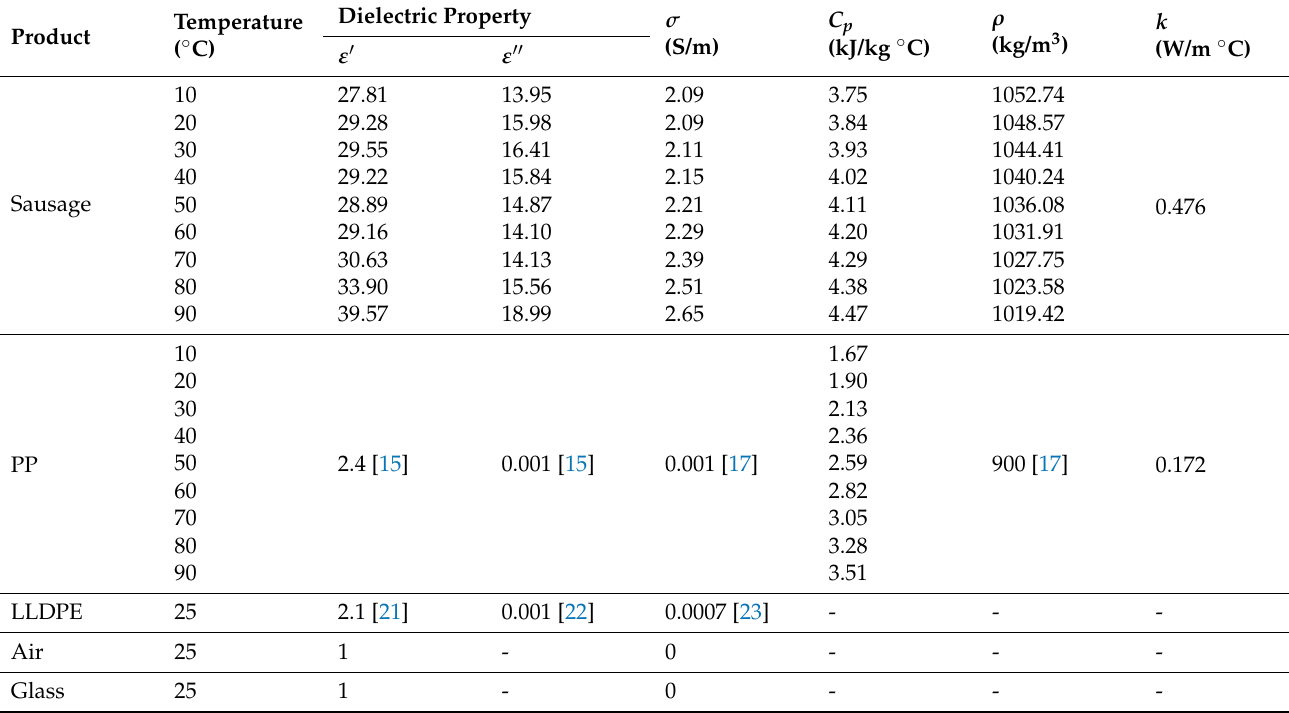
Table 1. Electrical and thermal properties of the sausage product and